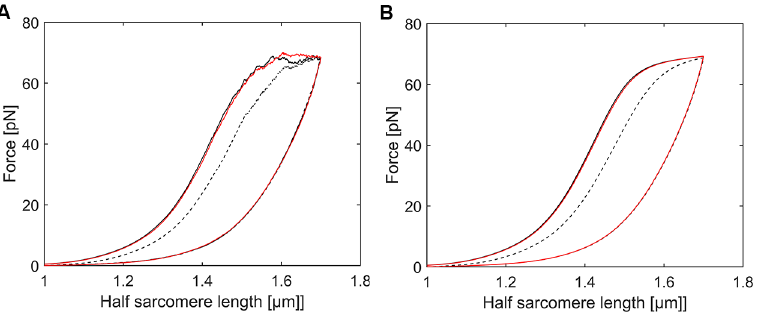
Fig 6. Repeated hysteresis loops. A Monte Carlo simulations and B exact solution of hysteresis loops based on one Ig cluster of the following setup: a half sarcomere was subject to two subsequent stretch- shortening cycles. After a resting period of 30s another stretch-shortening cycle was performed. We observed that while hysteresis was significantly reduced in the second cycle it fully recovered in the third cycle due to refolding of Ig domains in the resting period [5]. The effect of repeated stretch-shortening cycles on the unloading energy remains